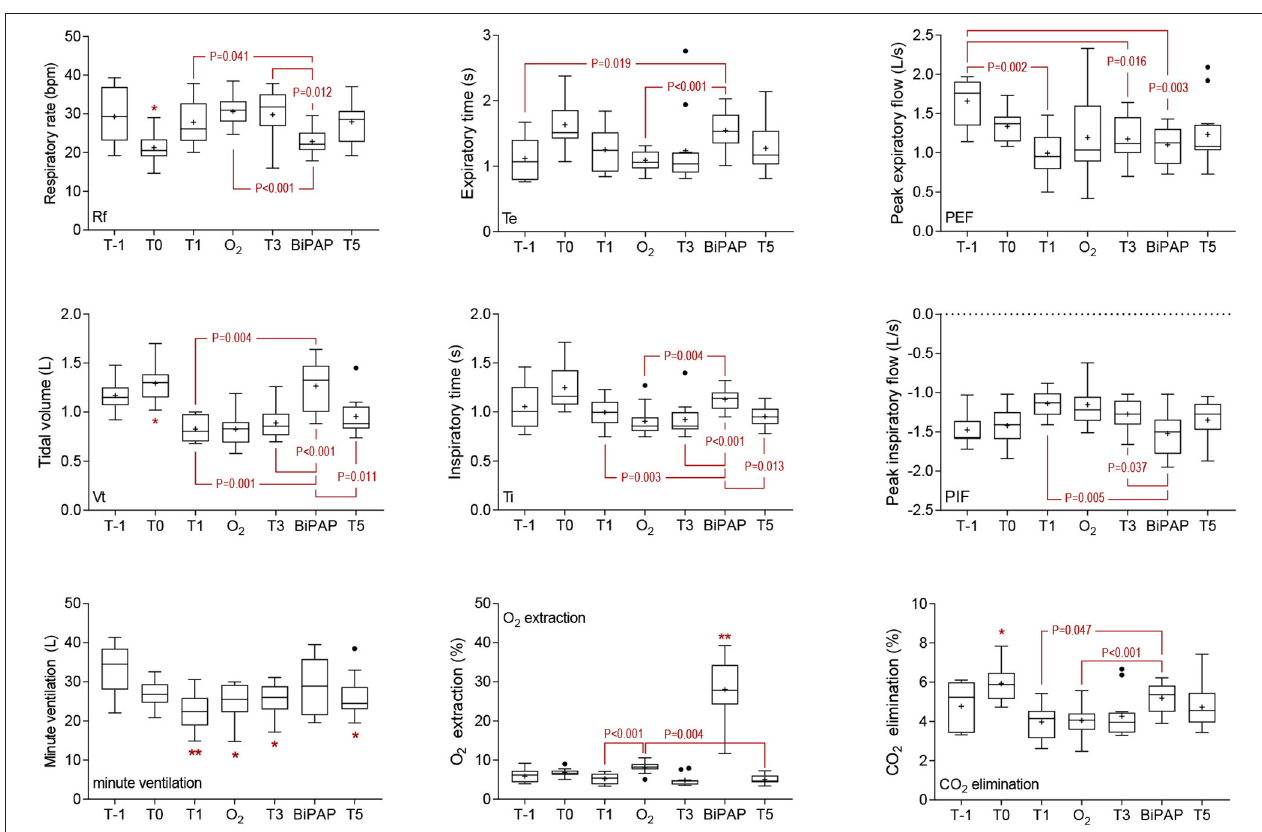
FIGURE 2 | Spirometry and gas exchange results. Sedation was associated with a significant decrease in respiratory rate during spirometry (RRs) at T0, and this effect was significant ( P < 0.05) in comparison with results at all other time points except during bi-level positive airway pressure ventilation (BiPAP). Effects on tidal volume (Vt) reciprocated those observed on RRs, with differences again observed at T0 ( P < 0.05 when compared to other sampling points with the exception of during BiPAP). Minute ventilation was greatest in standing, unsedated foals (T-1), and significant decreases were observed at all other sampling points (* P < 0.05 and ** P < 0.01) except during BiPAP. Inspiratory (Ti) and expiratory (Te) times were longest in standing foals following sedation with diazepam (T0), but significant effects were observed only in comparison with T5 ( P = 0.020) for Ti. For Te, comparisons between T0 and T-1 ( P = 0.008), O 2 ( P = 0.006), and T5 ( P = 0.012)